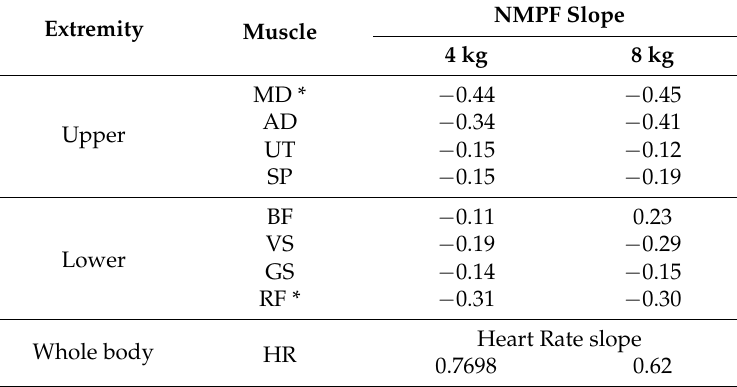
Table 2. NMPF slopes for the eight muscles of the lower and upper extremity and heart rate. A negative value indicates induced fatigue in muscle. Medial deltoid (MD), anterior deltoid (AD), upper trapezius (UT), supraspinatus (SP), bicep femoris (BF) vastus laterals (VS), gastrocnemius (GS), rectus femoris (RF), and heart rate (HR). NMPF Slope Extremity Muscle